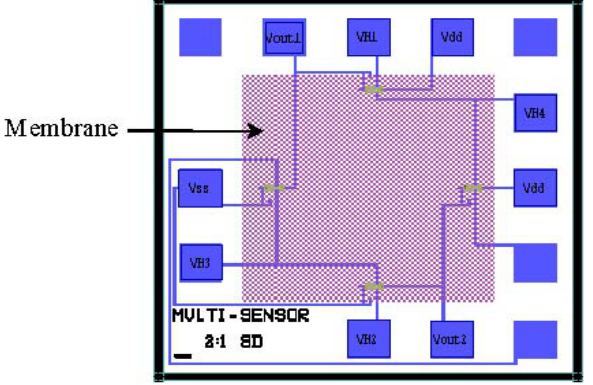
Figure 1. Mask layout of the nc-Si/c-Si heterojunction MOSFETs pressure sensor